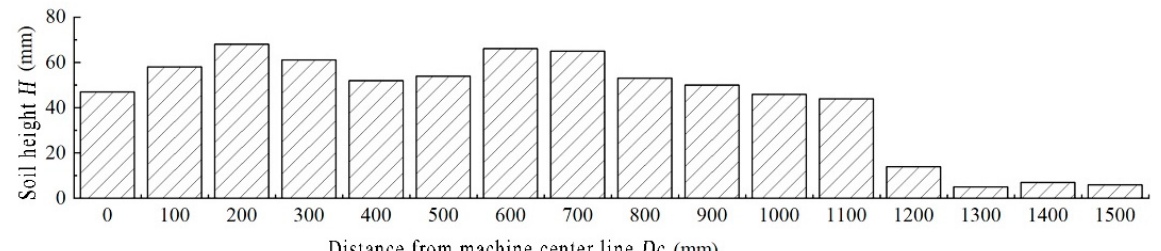
Figure 16. Field test results.